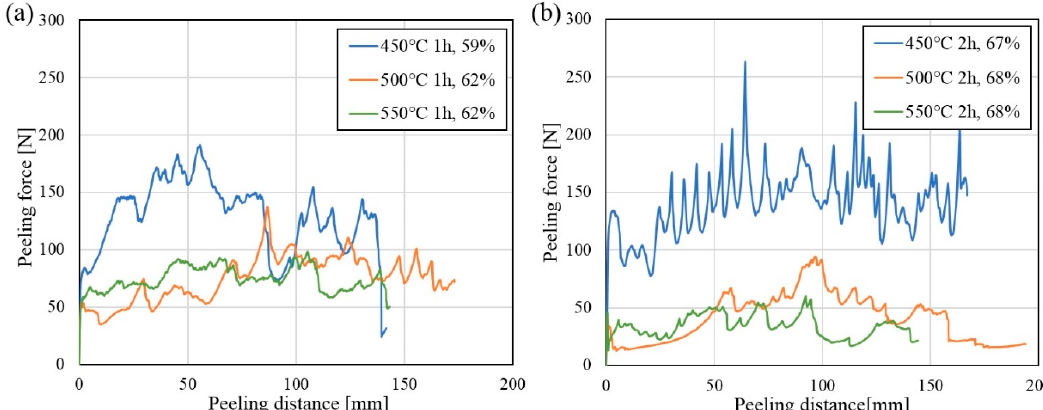
Figure 10. Effect of temperature on the peeling force necessary to delaminate the composites after heat treatment for ( a ) one hour and ( b ) two hours at 450 °C, 500 °C and 550 °C. One representative curve for each heat treatment is presented. The total thickness reductions of the composites are given in the legends.